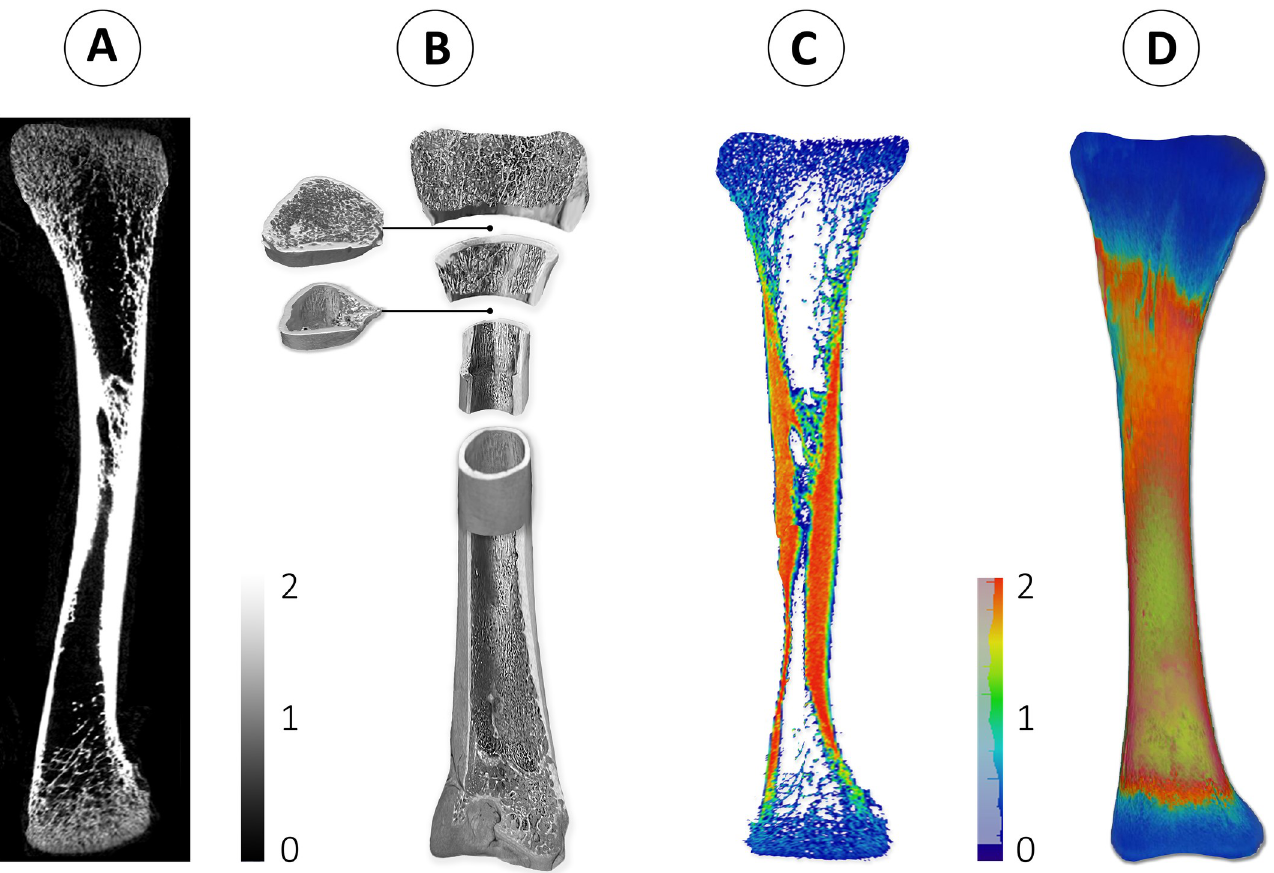
Fig 2. Illustrations of scanned bone by GE phoenix 3D X-ray microfocus CT scanner visualized in avizo 3D viewer software. A) Two-dimensional black and white (grey scale) tibia middle slice view. Shades of grey represent the mineralization areas of bone from dark grey (less mineralization) to white (more mineralization). B) Three-dimensional black and white (grey scale) tibia inner and outer view. C) Three-dimensional coloured tibia outer layer view. Colour scale represents the mineralization areas of outer bone from dark blue (less mineralization, 0) to red (more mineralization). D) Three-dimensional coloured tibia middle slice view. Colour scale represents the mineralization areas of bone from blue (less mineralization, 0) to green (more mineralization, 2).